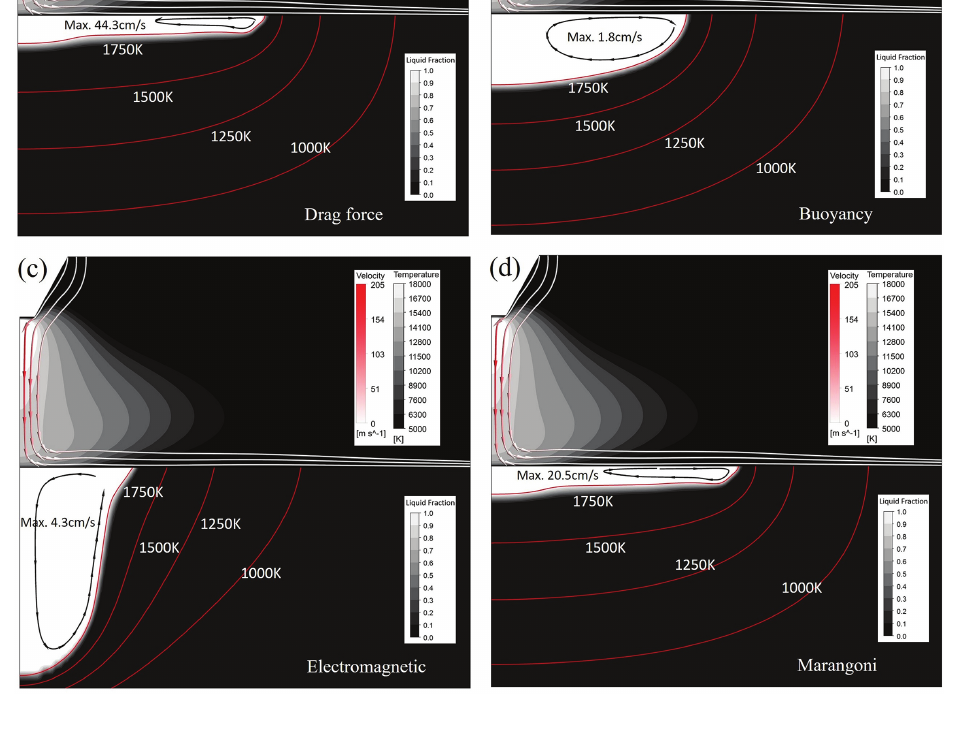
Figure 7: Fluid flow, tem- perature field and weld pool shape with different driving forces: (a) drag, (b) buoy- ancy, (c) electromagnetic force and (d) Marangoni force.